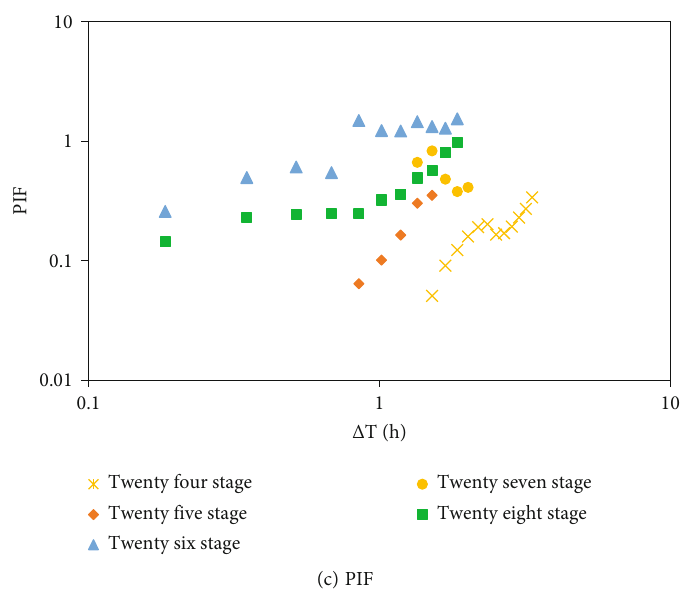
Figure 5: The Δ P , Δ P ′ , and PIF for each stage. Well LCG-1 is interfered with by well LCG-2 fractured at stages 24, 25, 26, 27, and